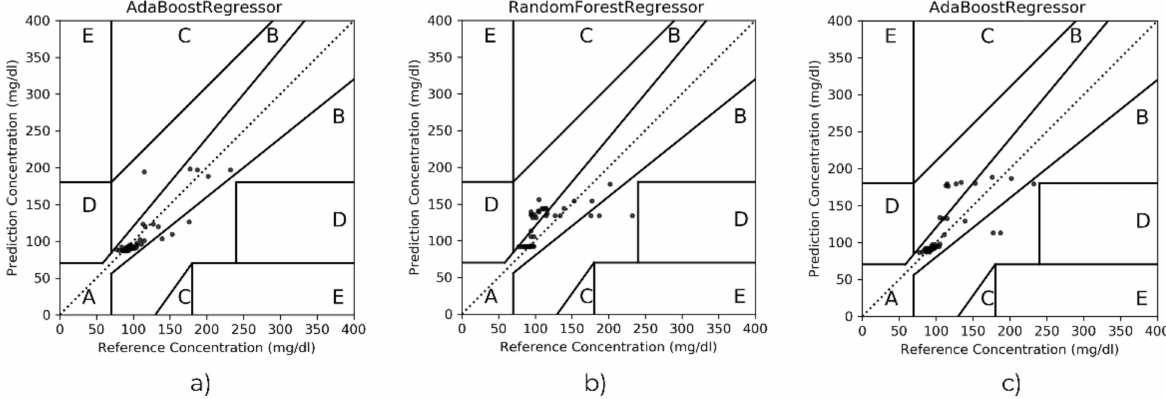
Figure 4. Clarke error grid results using ( a ) MFCC, ( b ) PCA and ( c ) ICA feature extraction